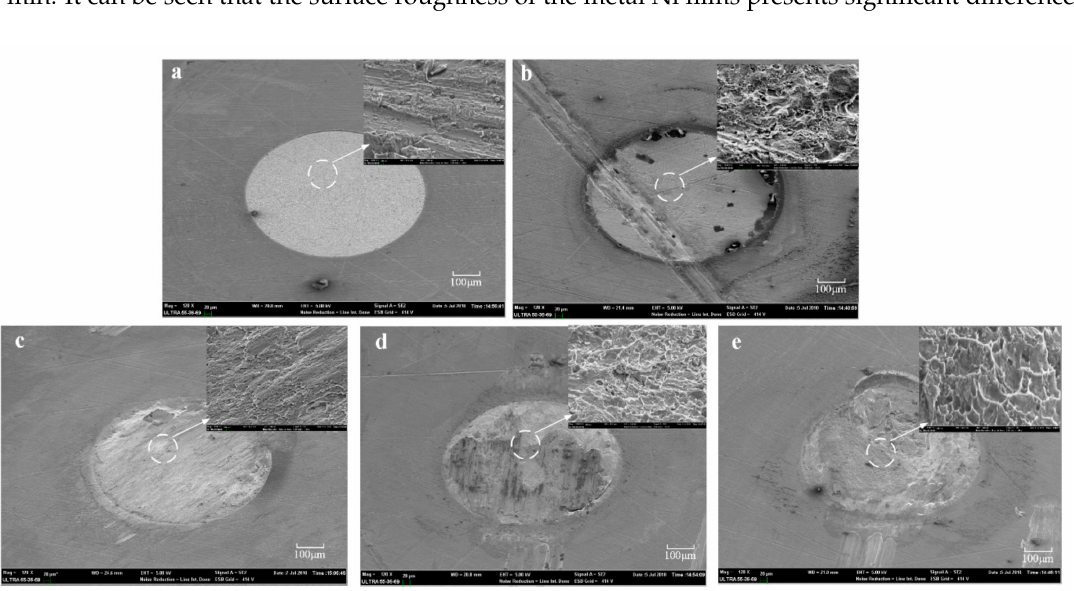
Figure 5. Fracture morphologies of the Ni films treated with different methods: ( a ) untreated; ( b ) 5 vol % HCl with 10 min; ( c ) anodic current of 10 mA with 10 min; ( d ) treated with anodic current of 20 mA with 10 min; ( e ) treated with anodic current of 30 mA with 10 min.